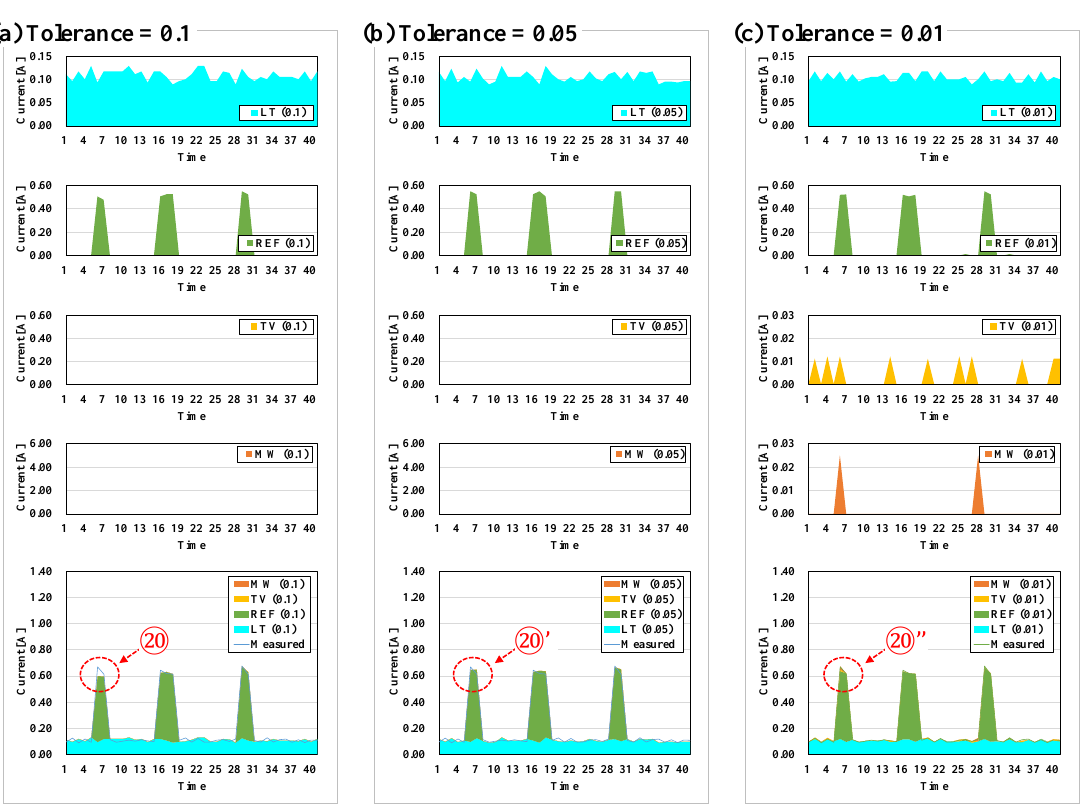
Figure 13. Load disaggregation of LT + REF by tolerance: ( a ) Tolerance = 0.1; ( b ) Tolerance = 0.05; ( c ) Tolerance = 0.01.